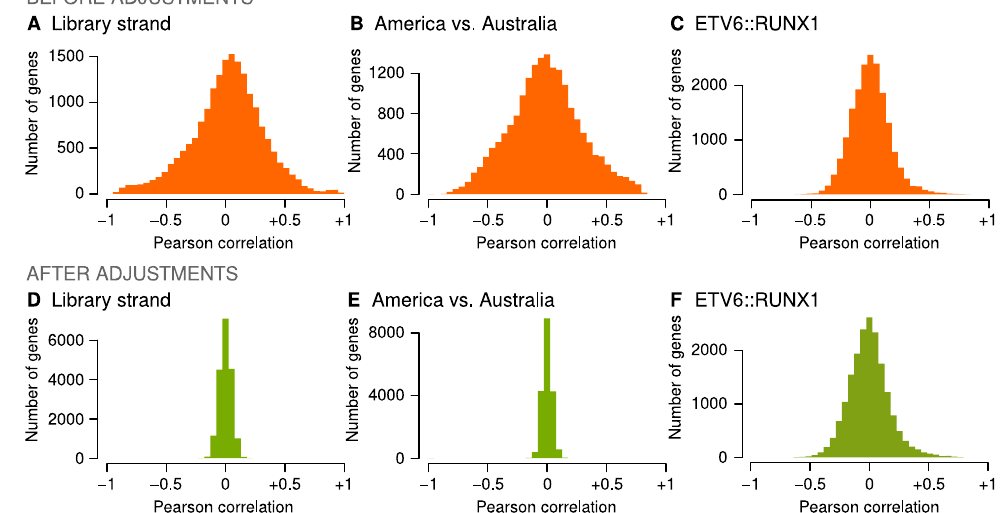
Figure 2. Impact of confounder adjustments. Pearson correlation coefficients were calculated between 18,503 log-transformed genes, and a technical or clinical variable before and after gene expression levels were adjusted as described in Methods. A wide histogram indicates substantial covariation across the transcriptome, while a narrow histogram indicates successful removal of covariance. ( A , D ) The North American cohorts included 204 (16%) RNA samples that were sequenced with an unstranded library. ( B , E ) Strandedness and other technical differences manifested as substantial covariation between the transcriptome and the continent of origin. ( C , F ) Covariation between gene expression and ALL subtypes, such as ETV6::RUNX1, was preserved.